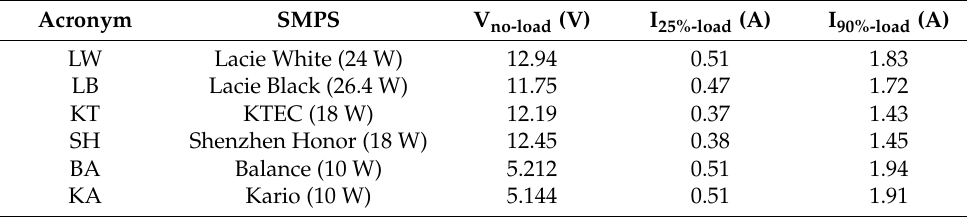
Table 1. Characteristics of the tested SMPSs: brand and model, no-load voltage and current delivered to the load at the scheduled 25% and 90% load conditions.